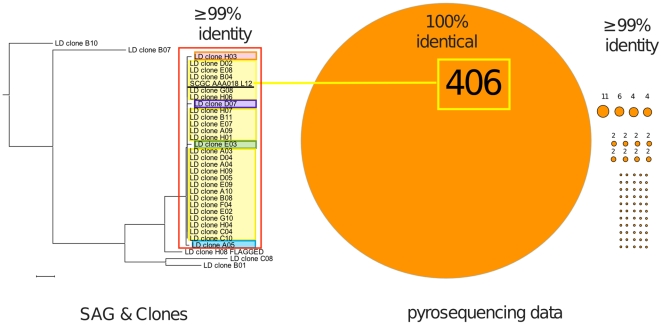
Microdiversity of L. ochracea clones and pyrosequencing reads.The Neighbor-Joining tree was constructed using the Jukes-Cantor substitution model with sequences of the hypervariable region V4 of the SSU rRNA gene from SAG and clones that matched the Lepto175 probe. Ribotypes boxed in red had ≥ 99% identity to one another and each highlighted clone(s) represent a unique ribotype in the clone library. Each circle or dot represents a unique ribotype of L. ochracea found in the pyrosequencing library that was either ≥100 or 99% identical to L. ochracea SAG and clones boxed in yellow.